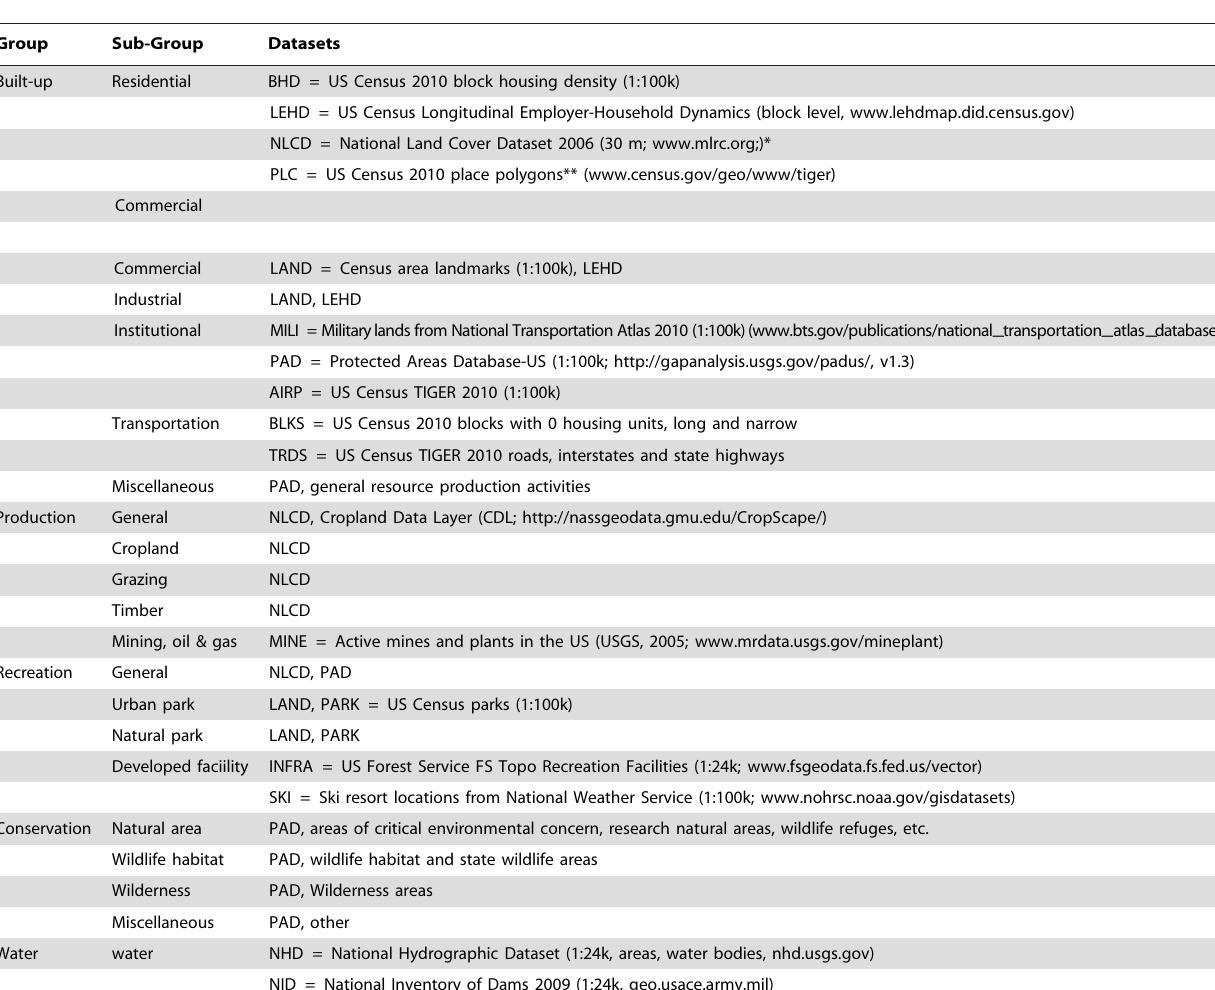
Table 2. Datasets used to construct the national land use